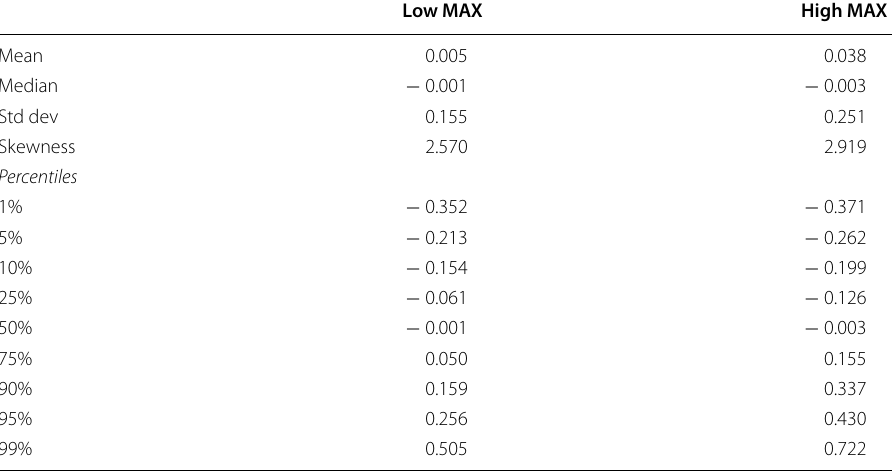
Decile portfolios are formed every week from January 2014 to September 2020 by sorting cryptocurrencies according to maximum daily return (MAX) within the previous month. The table presents descriptive statistics for the